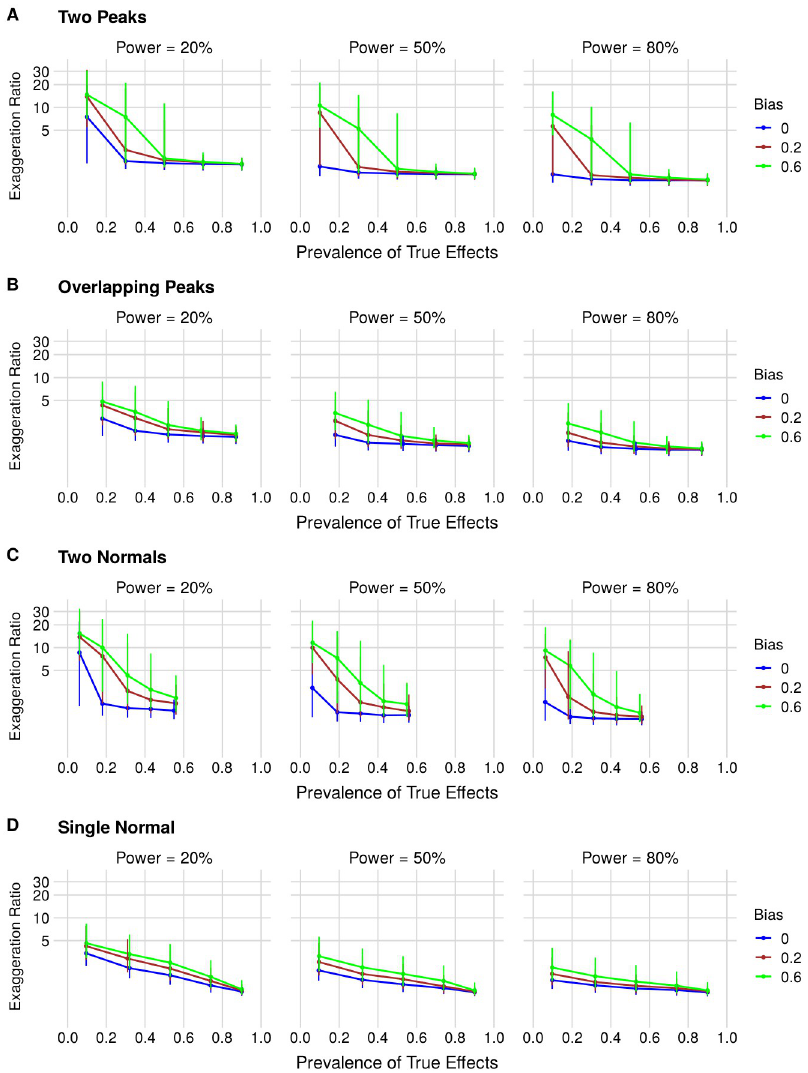
Fig 4. Type M error (i.e. effect size exaggeration) as a function of the prevalence of true effects, statistical power and bias for (A) Two Peaks, (B) Overlapping Peaks, (C) Two Normals and (D) Single Normal effect size distributions. Each point corresponds to the median exaggeration ratio for 5,000 published effects in the simulated literature, with error bars indicating the interquartile range. The Y axis represents the exaggeration ratio in a log scale to allow better visualization. In each panel, graphs correspond to 20%, 50% and 80% power from left to right. Blue, red and green curves correspond to bias of 0, 0.2 and 0.6, respectively. Prevalence ranges vary among scenarios, as for some distributions some prevalences cannot be achieved without changing other